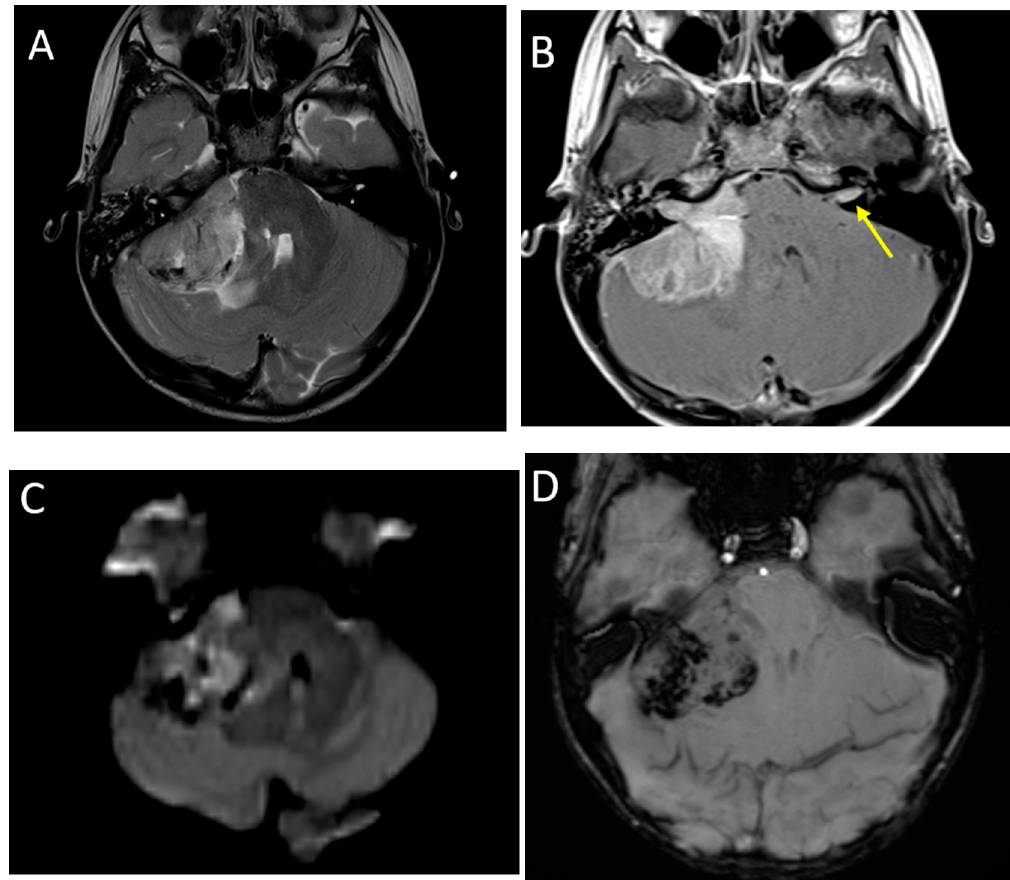
Figure 4. A 2.5-year-old girl with AT/RT. Axial T2 ( A ), post-contrast T1 ( B ), images demonstrate a heterogeneous lesion in the right cerebellopontine angle extending into the internal auditory canal. There is also a metastatic lesion in the left IAC (arrow). DWI ( C ) and SWI ( D ) imaging demonstrate restricted diffusion and susceptibility common in these lesions.